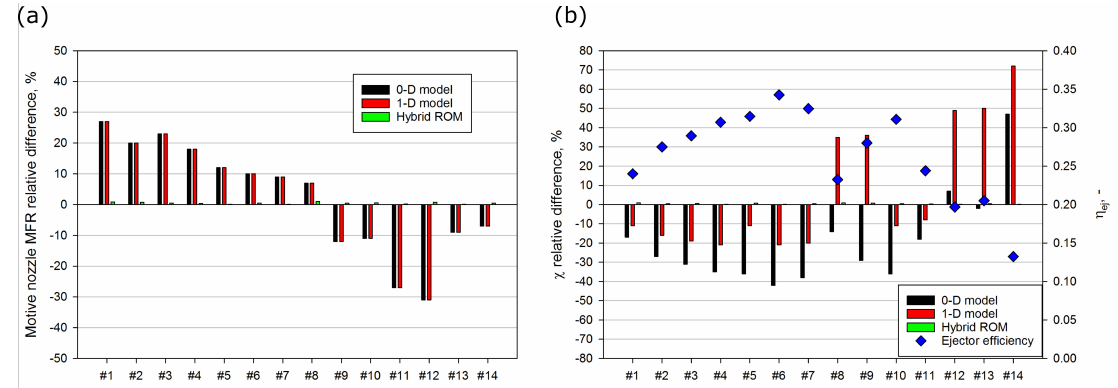
Figure 6. Relative difference between numerical result for each the R744 two-phase ejector mathematical model and measurements: ( a ) the motive nozzle mass flow rate (MFR); ( b ) the mass entrainment ratio together with the ejector efficiency given from the experimental data.